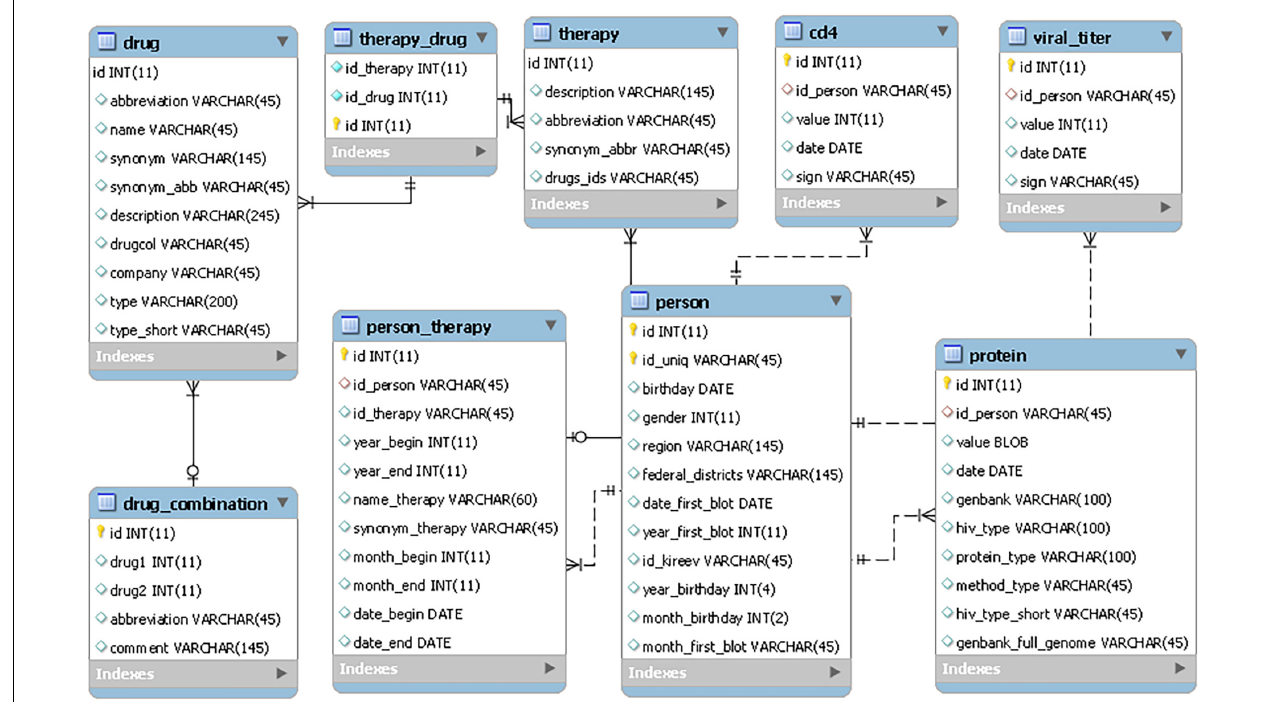
FIGURE 1 | The RHIVDB database